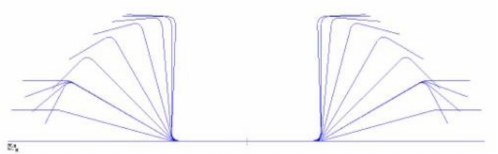
Figure 6. A reasonable flower diagram.